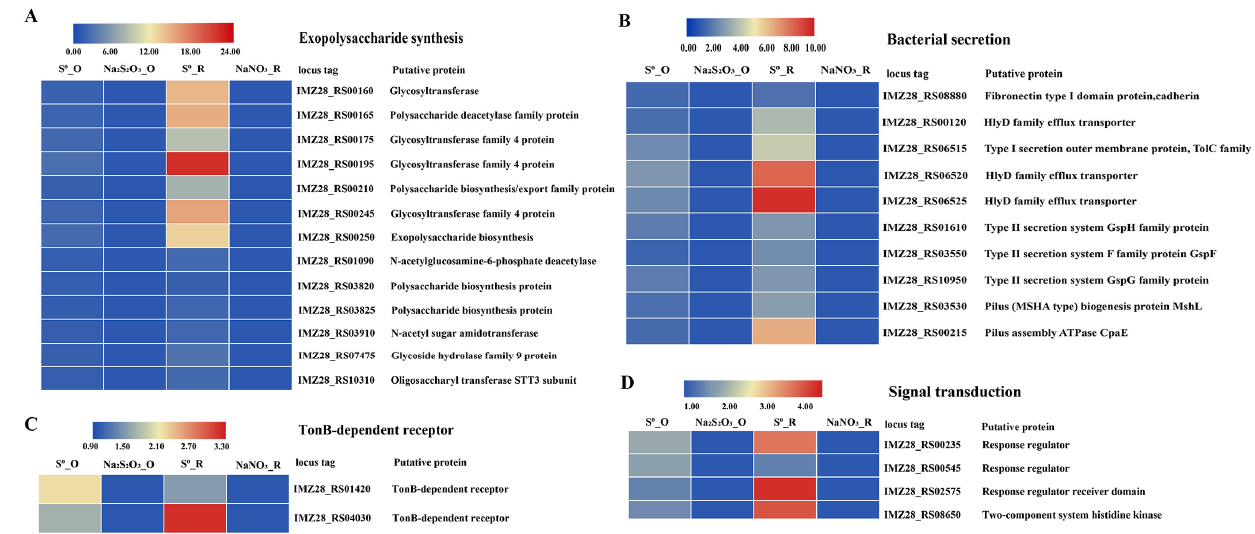
Figure 3. Transcriptomic analysis of genes associated with biofilm formation of strain ST-419 between S 0 oxidation and reduction. Heat map analysis of differentially expressed genes related to exopolysaccharide synthesis ( A ), bacteria secretion ( B ), TonB-dependent receptors ( C ) and signal transduction ( D ). S 0 _O represents S 0 oxidation; Na 2 S 2 O 3 _O represents thiosulfate oxidation; S 0 _N represents S 0 reduction and NaNO 3 _N represents nitrate reduction.